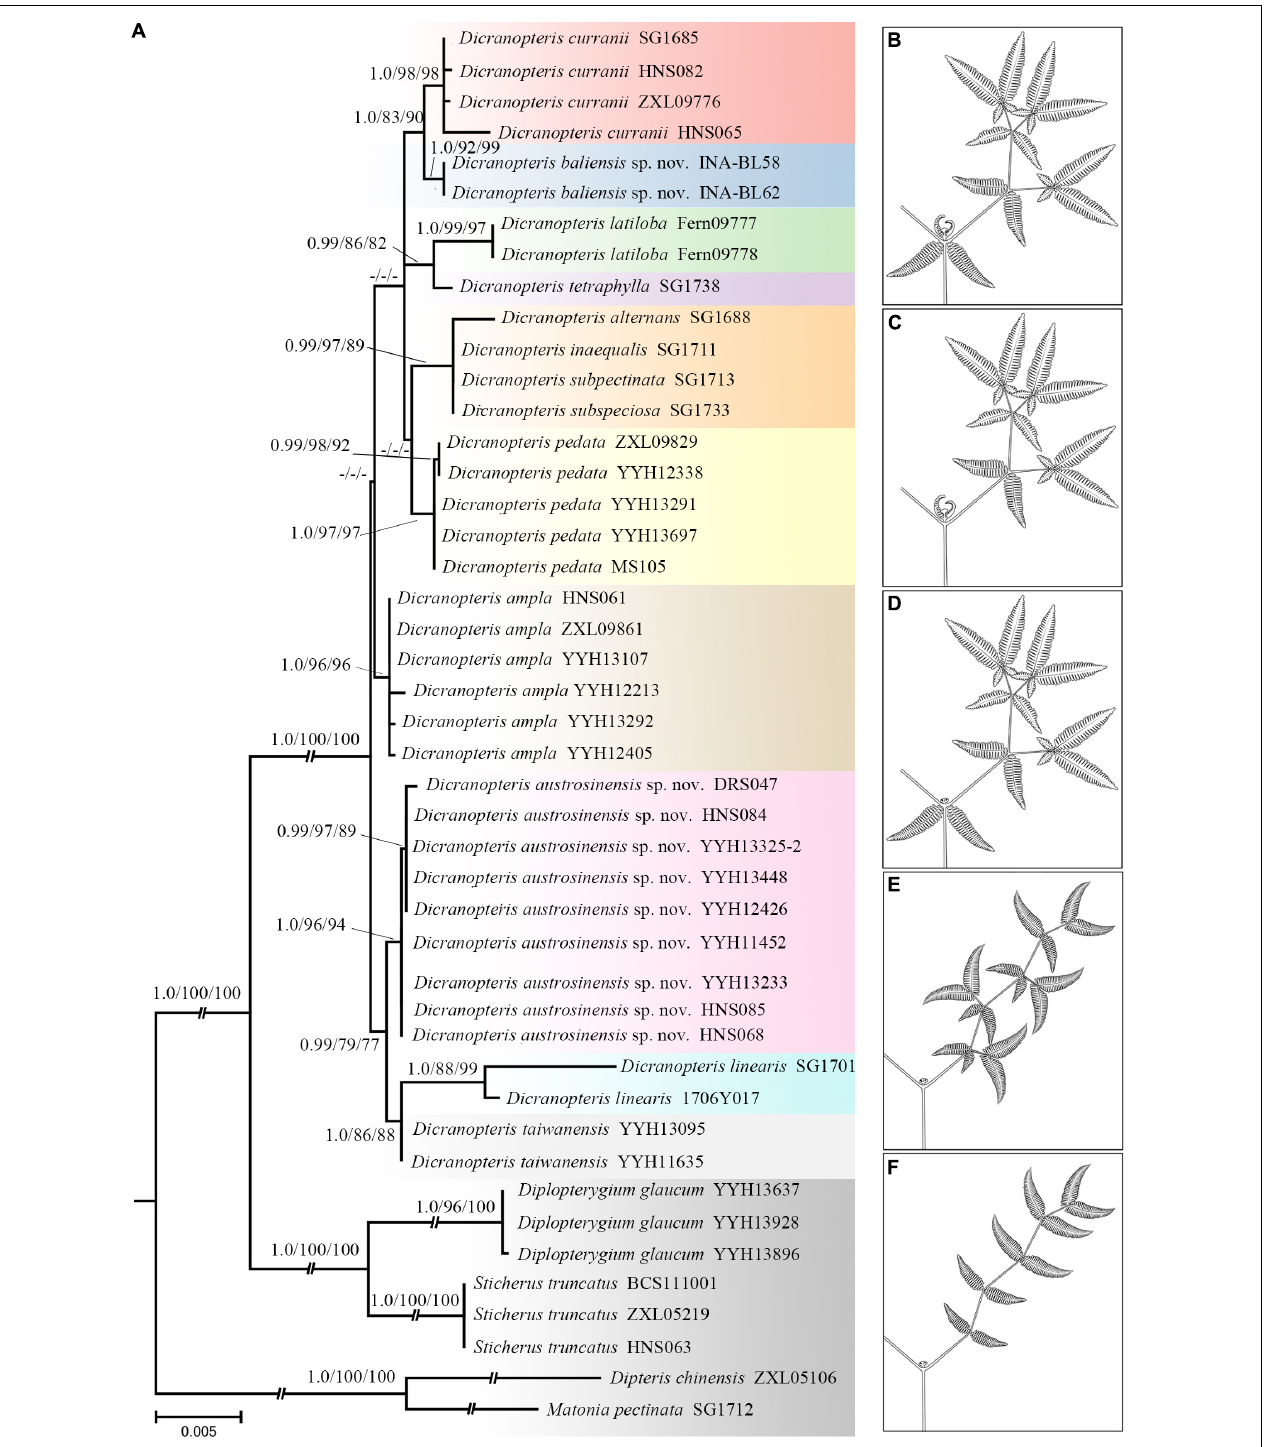
FIGURE 2 | It showing phylogeny and the main morphological diagnostic features of Dicranopteris (drawn by LJC). (A) ML tree of Dicranopteris based on the concatenation of rbcL, atpB, rps4, matK, and trnL-trnF . Numbers above each branch are support values in the order of posterior probability from Bayesian analysis (BIPP), bootstrap percentages of maximum likelihood analysis (MLBS), and bootstrap percentages of maximum parsimony (MPBS). The dash (-) indicates a node with BIPP < 0.9, MLBS < 70%, MPBS < 70%. (B) A latend bud with stipule-like pseudostipules always presents at the primary fork and ultimate fork. (C) The primary fork with terminal dormant buds and stipule-like pseudostipules. (D) The primary fork with a sterile bud. (E) Lateral branches forked more than three times and alternate unequal forking. (F) Lateral branches forked more than three times and without accessory branch.